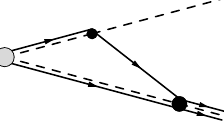
Figure 1. Feynman diagram in XEFT for D ∗ D ∗ created at a point to π . The π , D , D ∗ and T + rescatter into T + are represented by a dashed line, cc cc a solid line, a double (solid + dashed) line, and a triple (solid + dashed + solid) line,